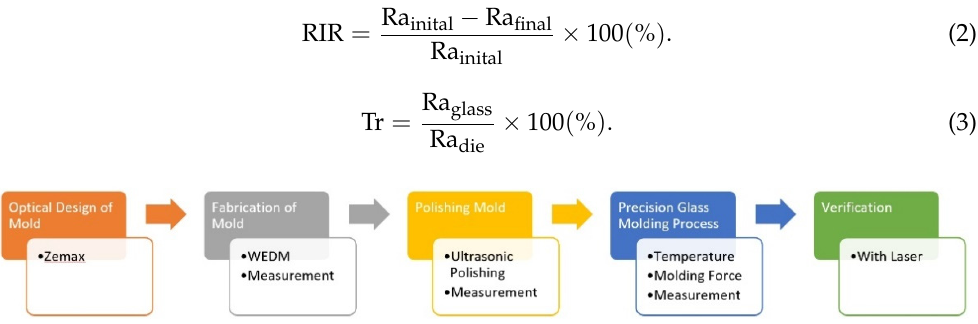
Figure 5. Flowchart of the experimental procedure to make the MLA .